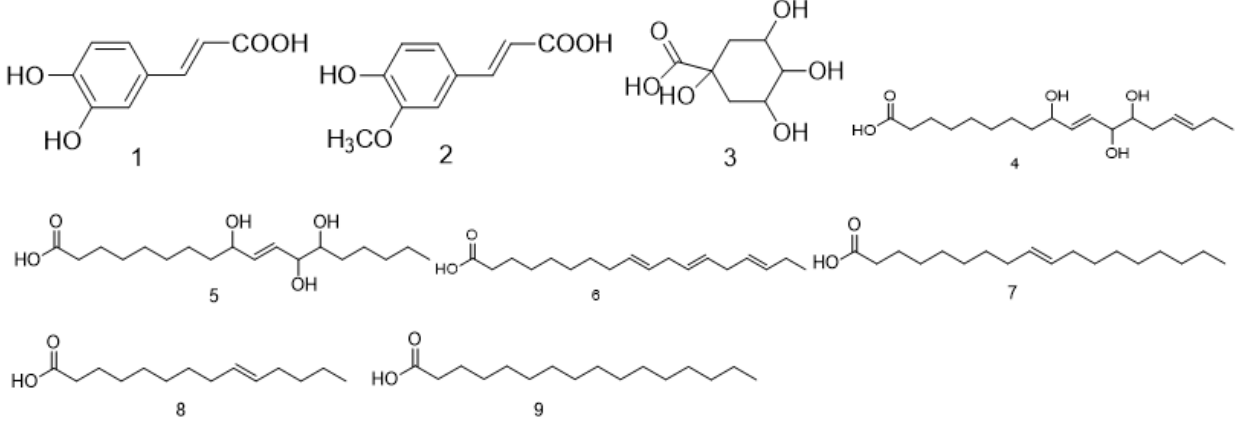
Figure 2. The chemical structures of acid compounds identified from Fructus Malvae .